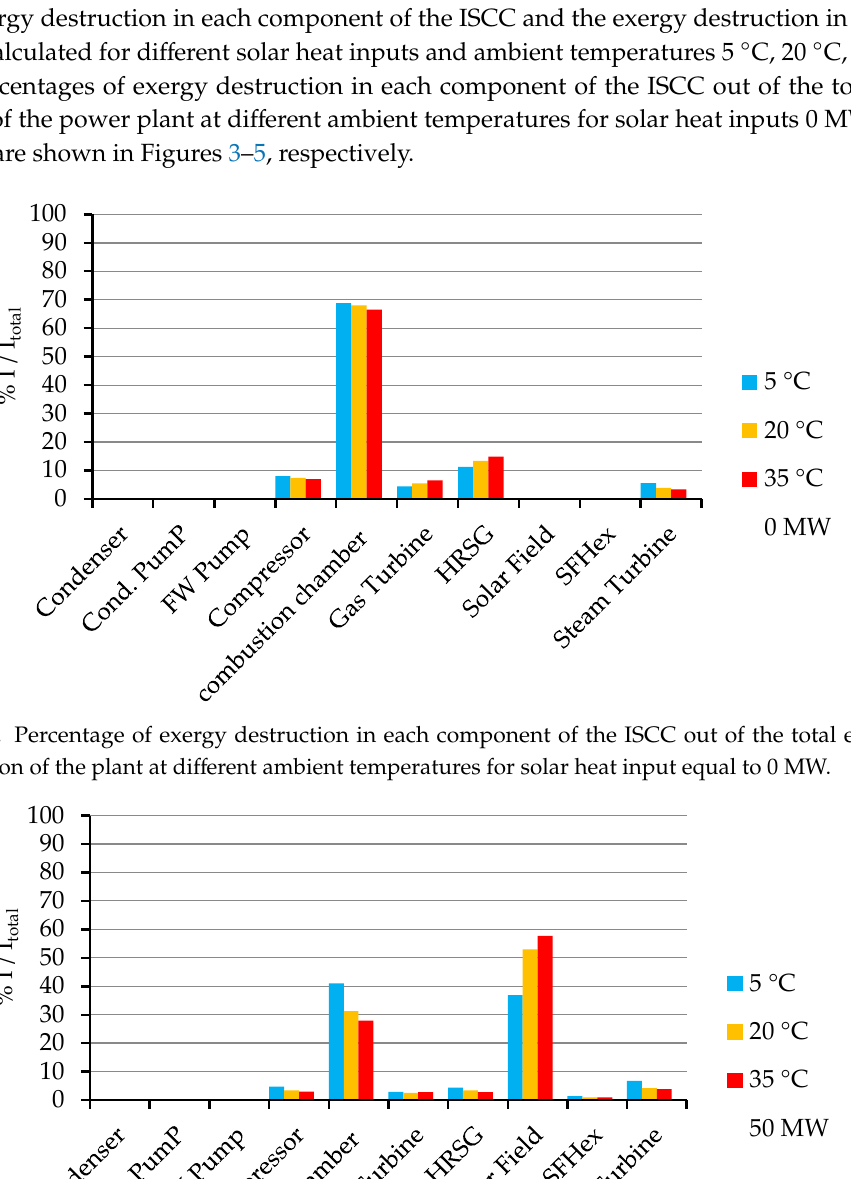
Figure 4. Percentage of exergy destruction in each component of the ISCC out of the total exergy destruction of the plant at different ambient temperatures for solar heat input equal to 50 MW.